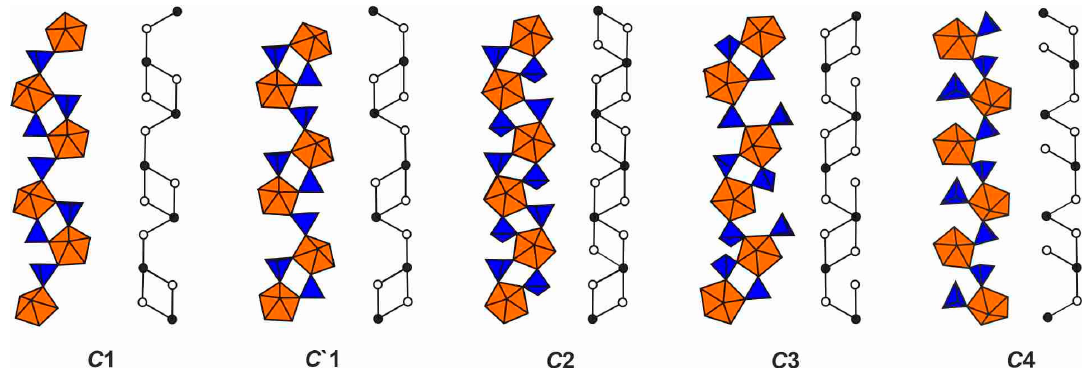
Figure 8. Fundamental chains with edge-sharing polyhedral in the structures of known layered topologies with UO 2 : T O 4 = 3:5 and known complex NT derivatives.